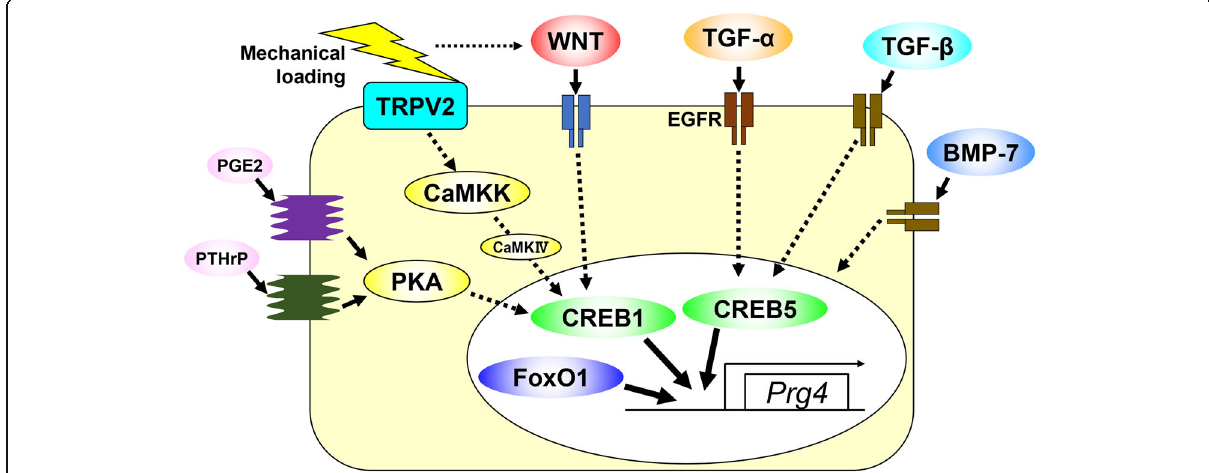
Fig. 2 Schematic diagram representing the molecular pathways that regulate PRG4